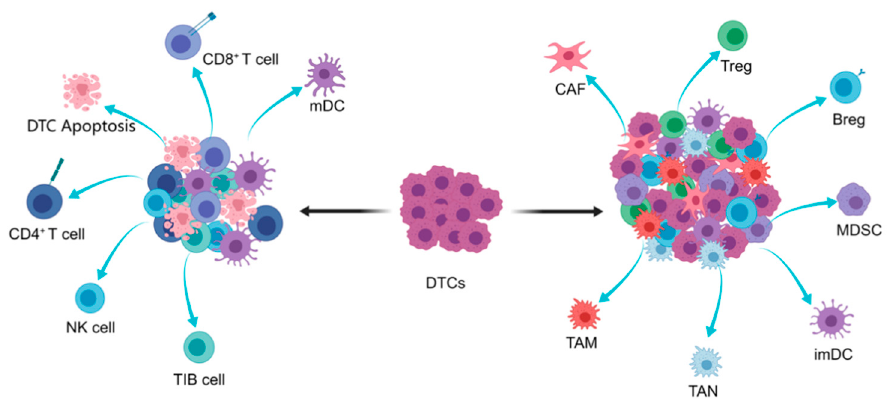
Figure 2. The interaction of immune cells and DTCs . As disseminated tumor cells extravasate, they encounter a foreign microenvironment with obstacles to survival. During this process, cellular components play key roles in the destiny of DTCs. Numerous interactions between cell types are involved throughout tumor progression and metastasis. If the microenvironment is filled with cytotoxic CD8 + T cells, mature DCs, and NK cells, DTCs will thus go into apoptosis ( left ). DTCs survive and proliferate within immunosuppressive microenvironments containing CAFs, TAMs, TANs, MDSCs, etc. ( right ).